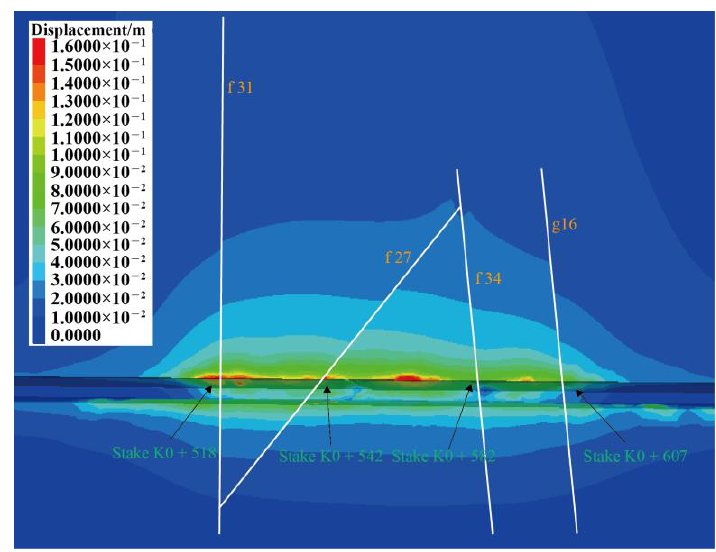
Figure 11. Displacements at stakes K0 + 500–K0 + 620 of the diversion tunnel.